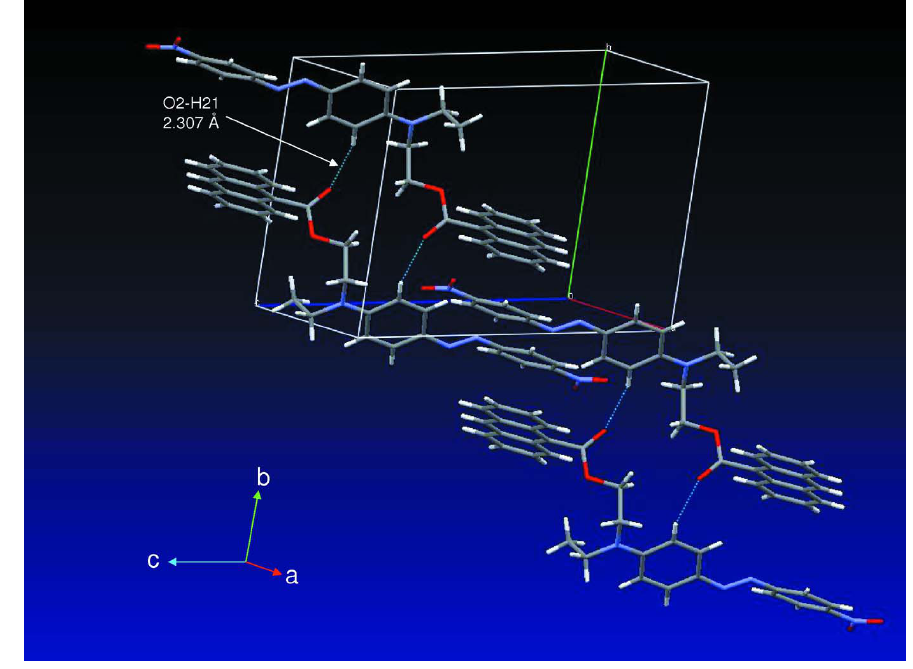
Figure 3 Packing diagram of (I) viewed down the a axis illustrating weak hydrogen bonding between the carbonyl oxygen (O2) and the neighboring molecule of (I). This interaction dictates the packing behavior of (I) along the b axis. ( E )-2-{Ethyl[4-(4-nitrophenyldiazenyl)phenyl]amino}ethyl